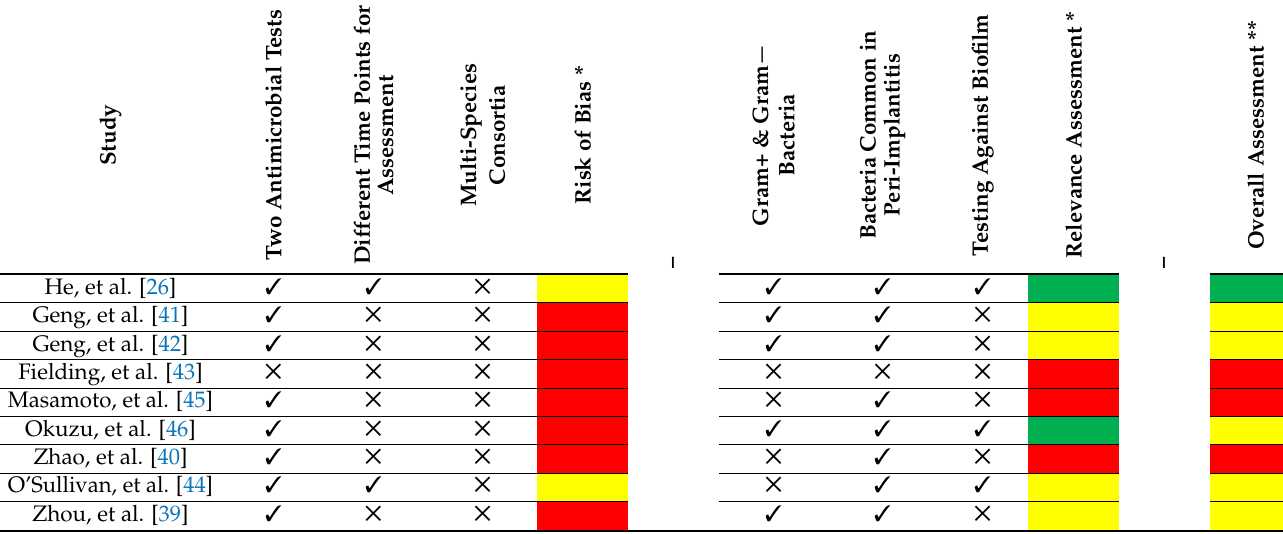
Table 3. For the overall assessment, only one study fulfilled five out of the six criteria [26], while five studies fulfilled three to four criteria, and three fulfilled two or less criteria. Table 3. Risk of bias and relevance assessment of the included